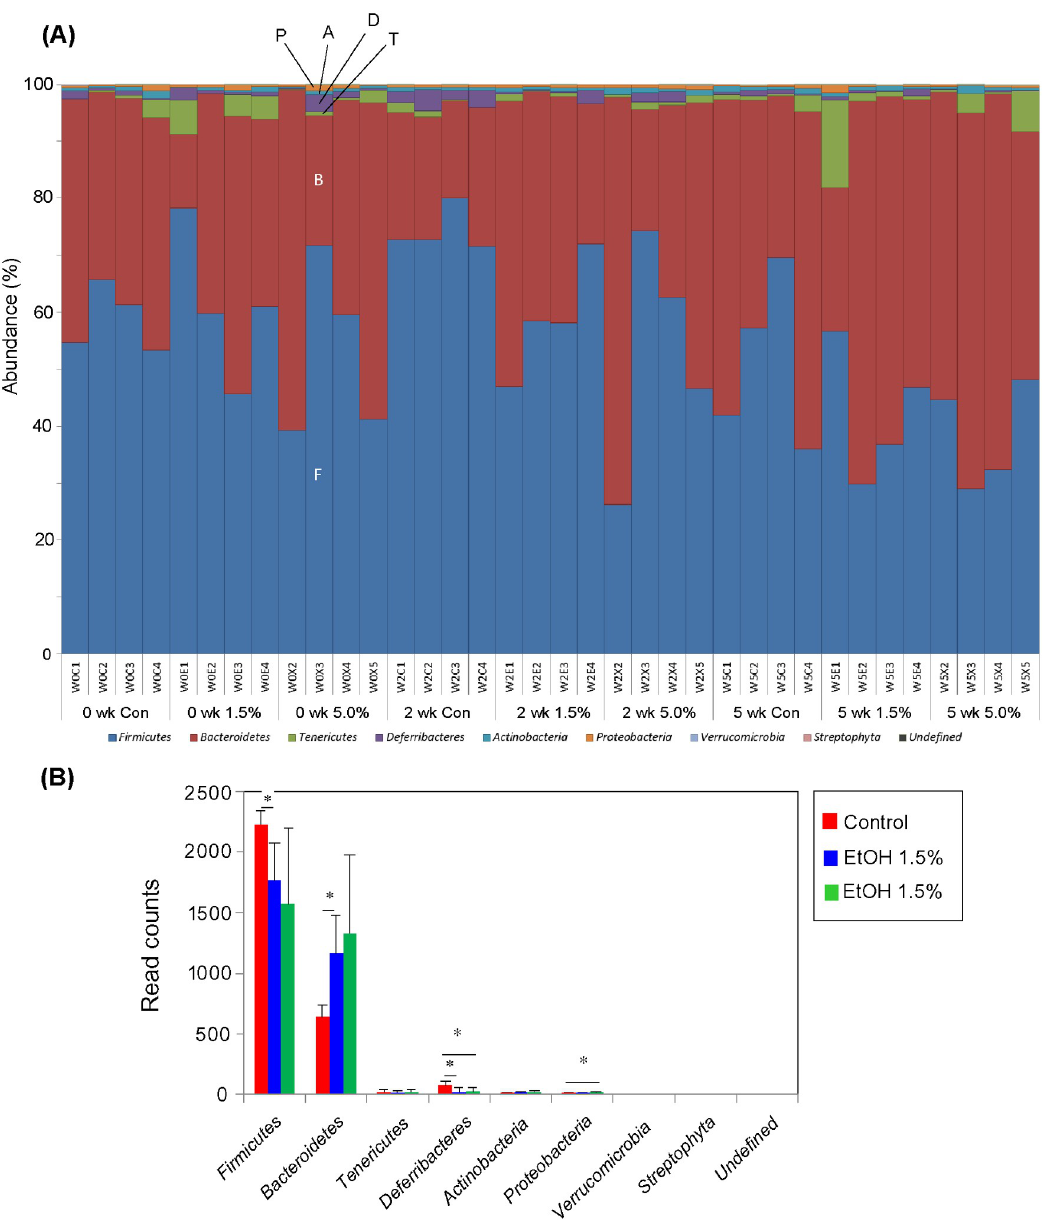
Fig 8. Relative abundances of bacterial phyla in the fecal bacterial communities of the three groups. (A) Relative abundances of bacterial phyla are compared among individual subjects. For subject names, see the legend to Fig 8 (B). Phyla shown are, from bottom to top, Firmicutes (F, blue), Bacteroidetes (B, brown), Tenericutes (T, green), Defferibacteres (D, purple), Actinobacteria (A, sky blue), Proteobacteria (P, orange), Verrucomicrobia (light blue), Streptophyta (pink), and unidentified (black). For convenience sake, the six top phyla are indicated with one-letter notation on the W0X3 bar. (B) Relative abundances of bacterial phyla are compared among at week 5 c ontrol (red), 1.5%-ethanol (blue), and 5.0%-ethanol (green) groups. Error bars indicate ± SD (n = 4) within the group. � p < 0.05 versus control, as assessed by Welch’s t